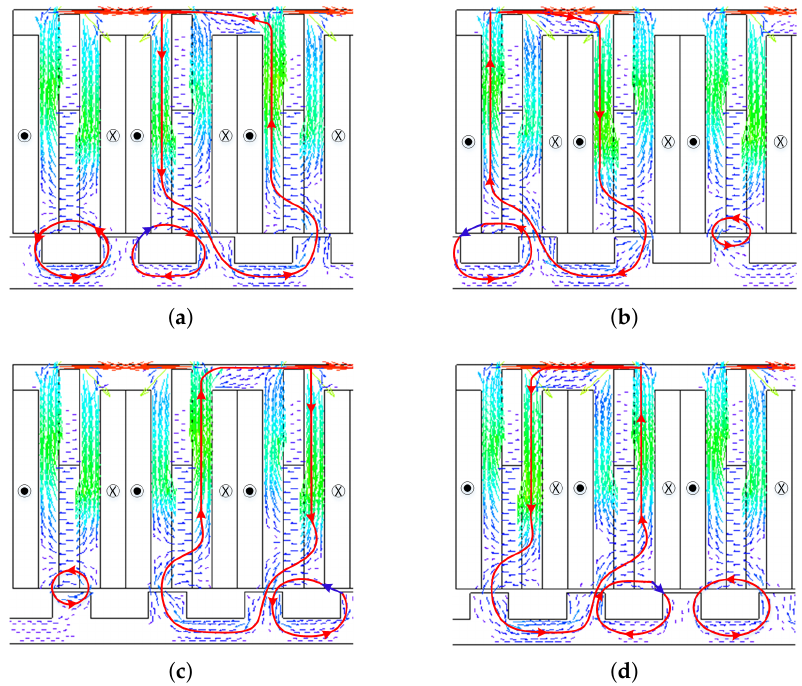
Figure 3. Principle of operation ( a ) θ = 0 o ( b ) θ = 90 o ( c ) θ = 180 o ( d ) θ = 270 o . Table 1. Design parameters of Single-sided VFPMLM.